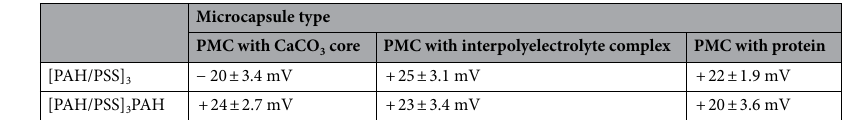
Table 1. Results of the study of the surface charge of polyelectrolyte